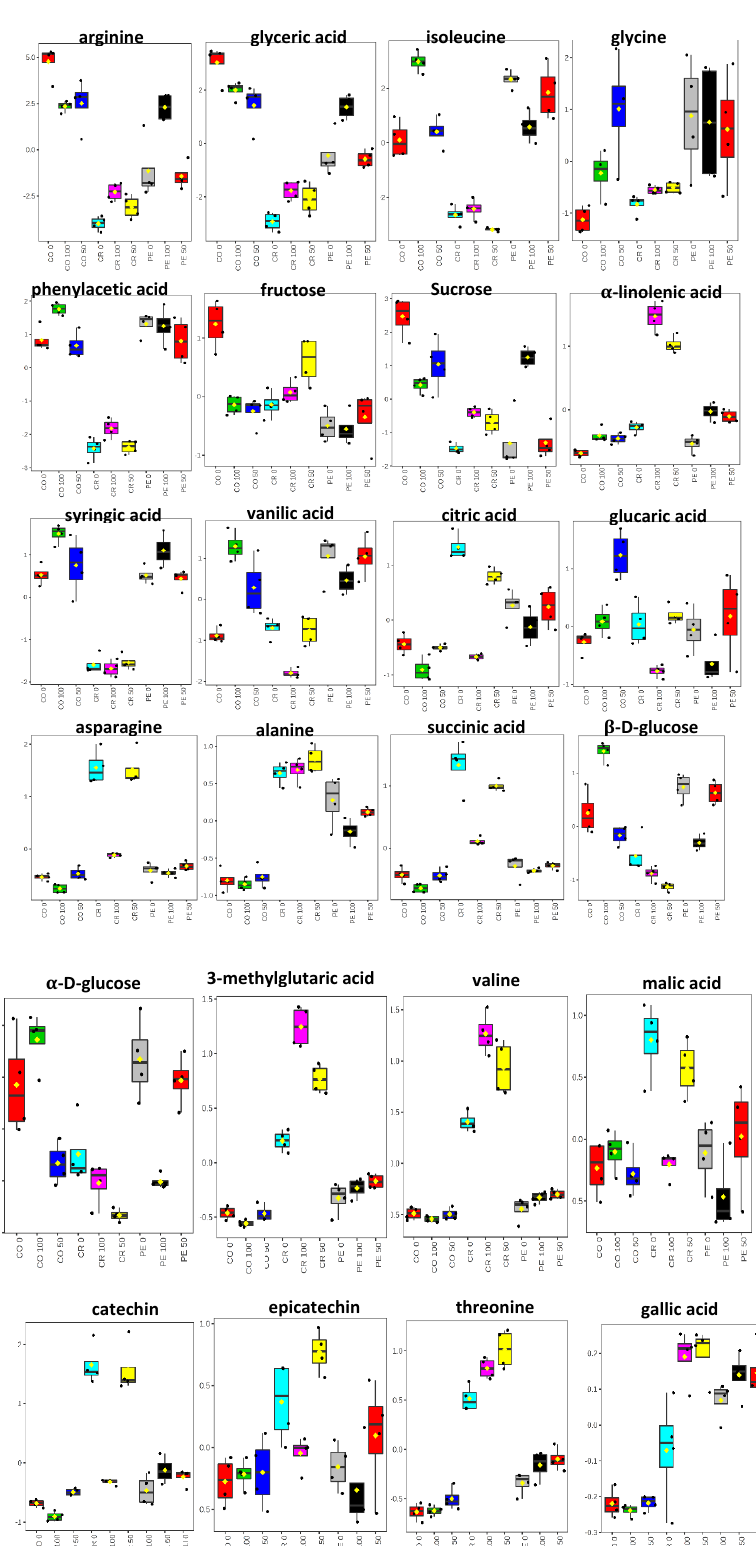
contributing to α -glucosidase inhibitory activity as shown in the PLS biplot, while fructose (1) and glucaric acid (30) are considered to have a weak contribution to α -glucosidase inhibitory activity. 4. Conclusions In conclusion, the current study demonstrated that MD2 pineapple peel, crown, and core extracted with 0%, 50%, and 100% ethanol ratios possessed variations in TPC, DPPH free radical scavenging activity, NO free radical scavenging activity, and α -glucosidase inhibitory activity. Based on the biological assays, MD2 pineapple crown extracted with a 100% ethanol ratio presented better scavenging effects on DPPH and NO free radical, scavenging, suggesting that it is a better antioxidant compared to peel and core. However, peel extracted with a 100% ethanol ratio exhibited bet ter α - glucosidase inhibition properties with an IC 50 value less than 100 µg/mL, which may act as α - glucosidase inhibitor. Regardless of different ethanol ratio extractions, MD2 pineapple core presented the lowest activity in all the bioassays examined. The 1 H NMR metabolomics successfully investigated the metabolite profiles of the MD2 pineapple peel, crown, and core extracted from different ethanol ratios. The current study provides valuable information regarding sample preparation methods for waste portions and the potential use of metabolomics for studying the correlation between plant metabolites and bioactivity. However, a more comprehensive study is needed to further understand the underlying mechanism of bioactive compounds obtained from MD2 pineapple waste extracts, and their toxicity and bioavailability after ingestion in order to help develop their applications as a functional food.